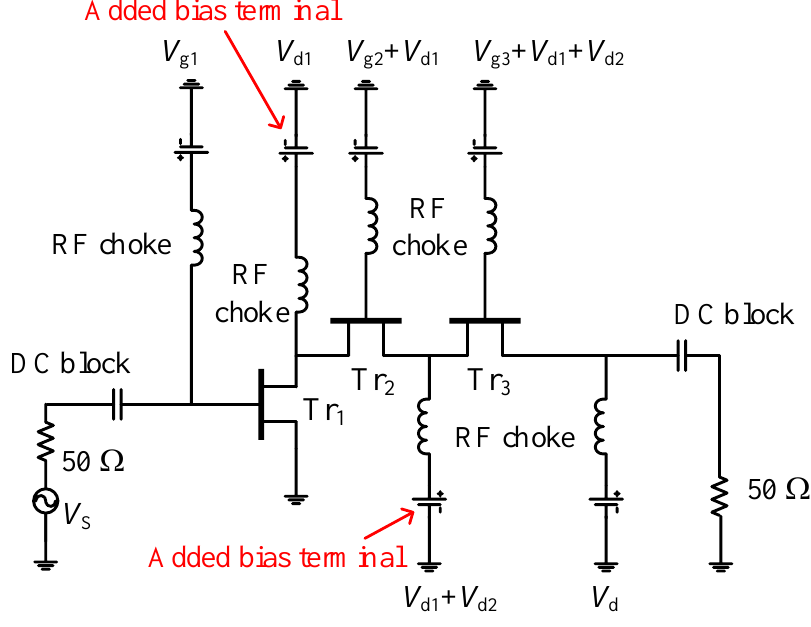
Figure 2. Simulation setup for S-parameters simulation in Keysight advanced design system